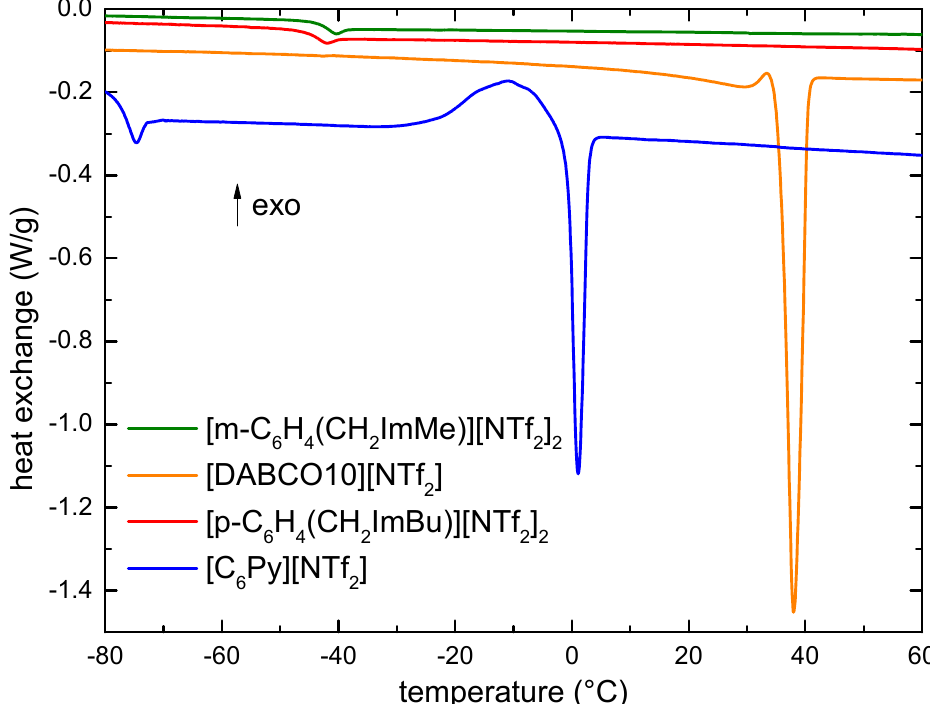
Figure 2. DSC traces measured on heating of the investigated ionic liquids.